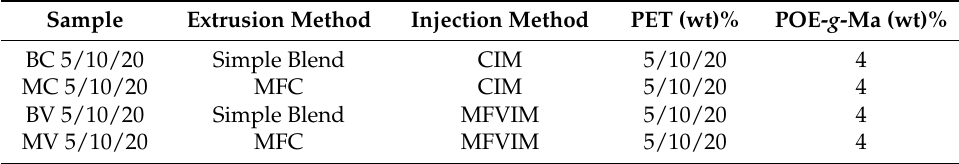
Figure 1. Scheme of experimental setup: ( a ) Blend + conventional injection molding (CIM) [BC], ( b ) microfibrillar composites (MFC) + CIM [MC], ( c ) blend + multiflow vibrate injection molding (MFVIM) [BV] and ( d ) MFC + MFVIM [MV]. Table 1. Blend composition and preparation method.